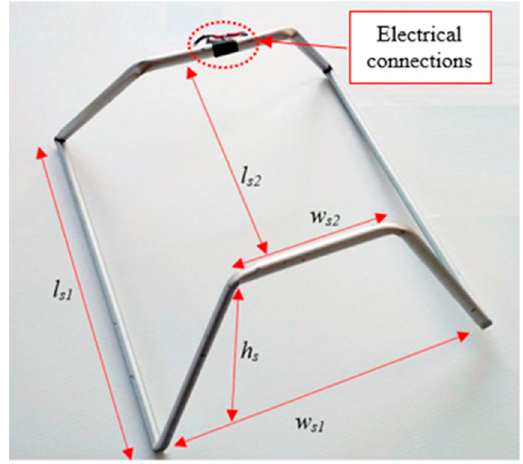
Figure 4. Landing gear configuration.